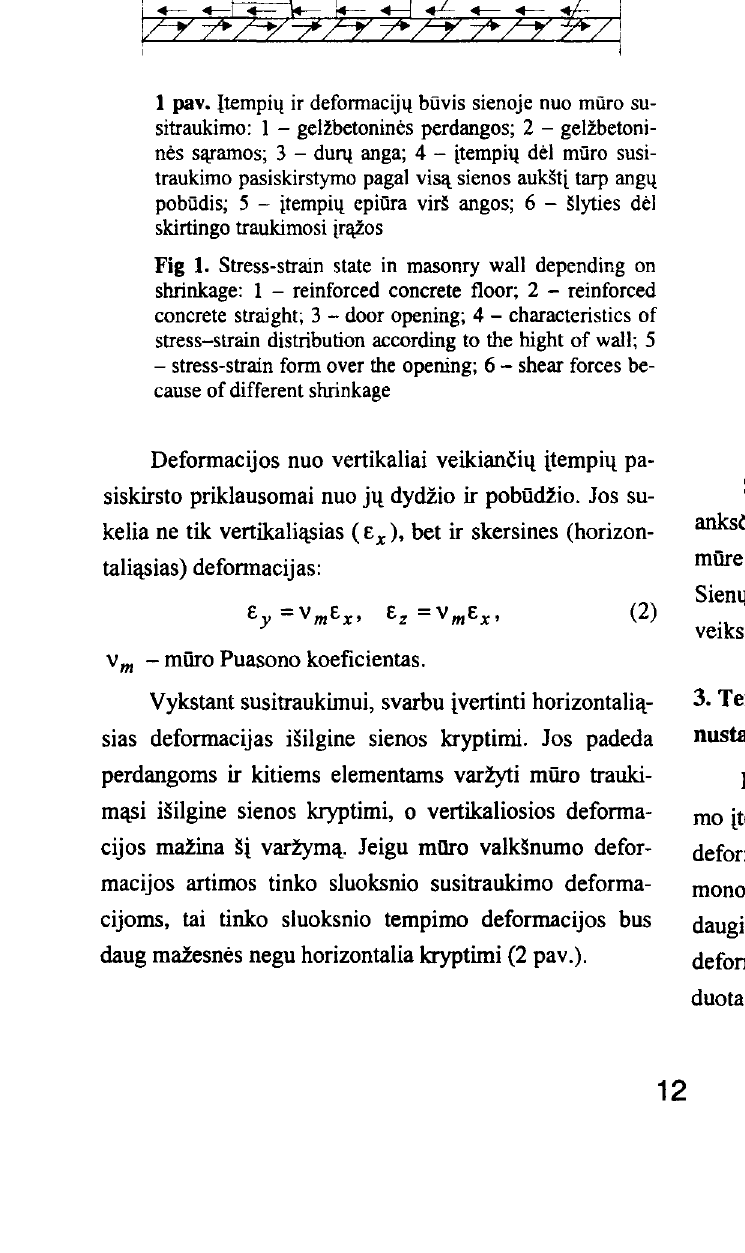
Fig 2. Influence of stress-strain state on loading for shrin kage deformation of masonry, when evaluating shrinkage: 1 - characteristics of changing vertical deformations of wall masonry; 2 - the same for horizontal; 3 - characte ristics of development of shrinkage deformation ( E sh ); EJ and e 2 is increment of horizontal and vertical deforma tions of masonry when decoration layer is